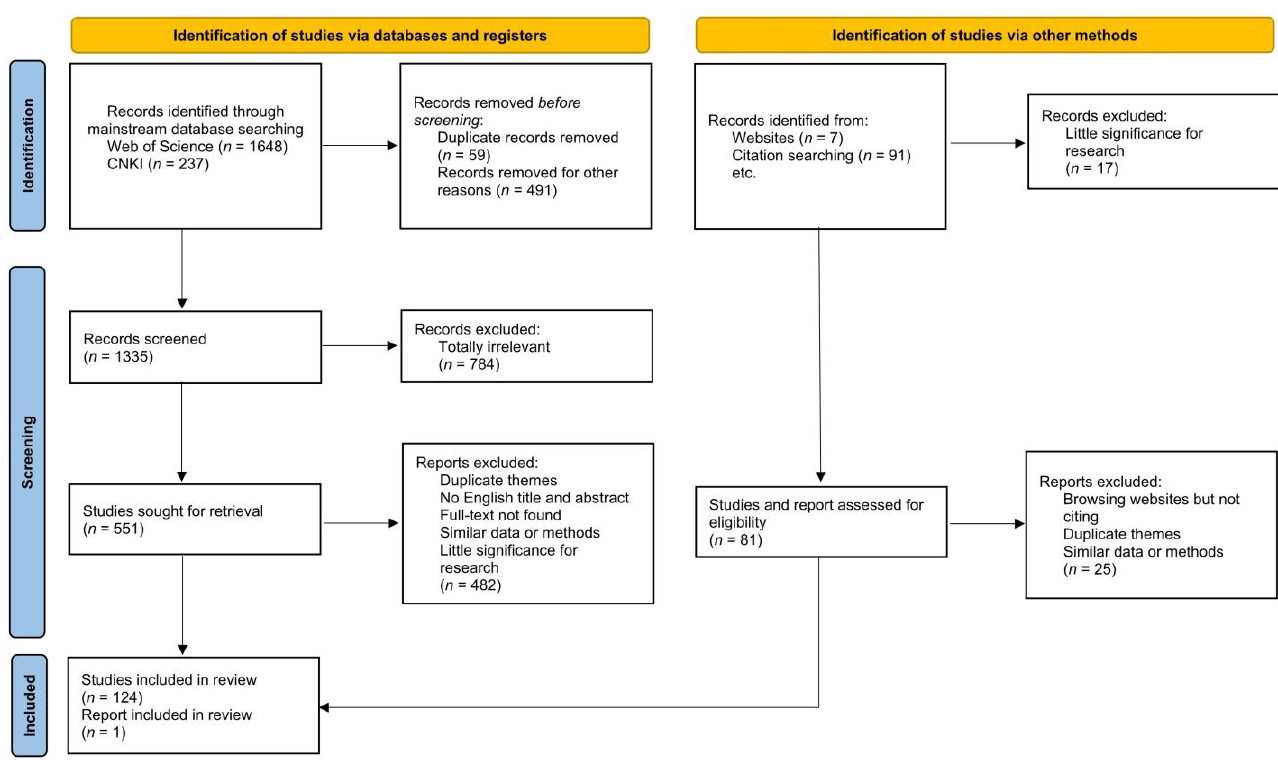
Figure 1. Preferred reporting items for systematic reviews and meta-analyses (PRISMA) flow diagram.